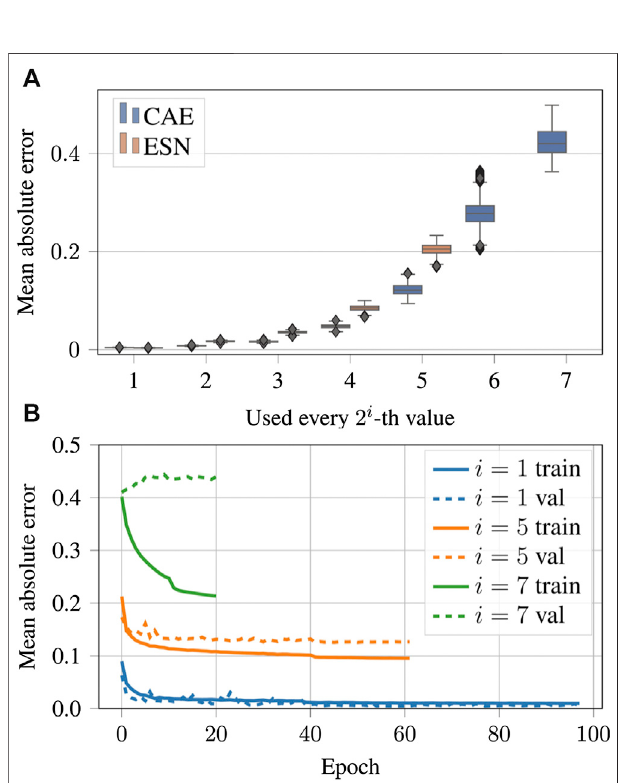
FIGURE13|(A) Sameas Figures9B butforthecaseoftheundersampled data.Atabularoverviewofthevaluescanbefoundin Table3 . (B) Evolutionofthe loss function values over the epochs for undersampled input